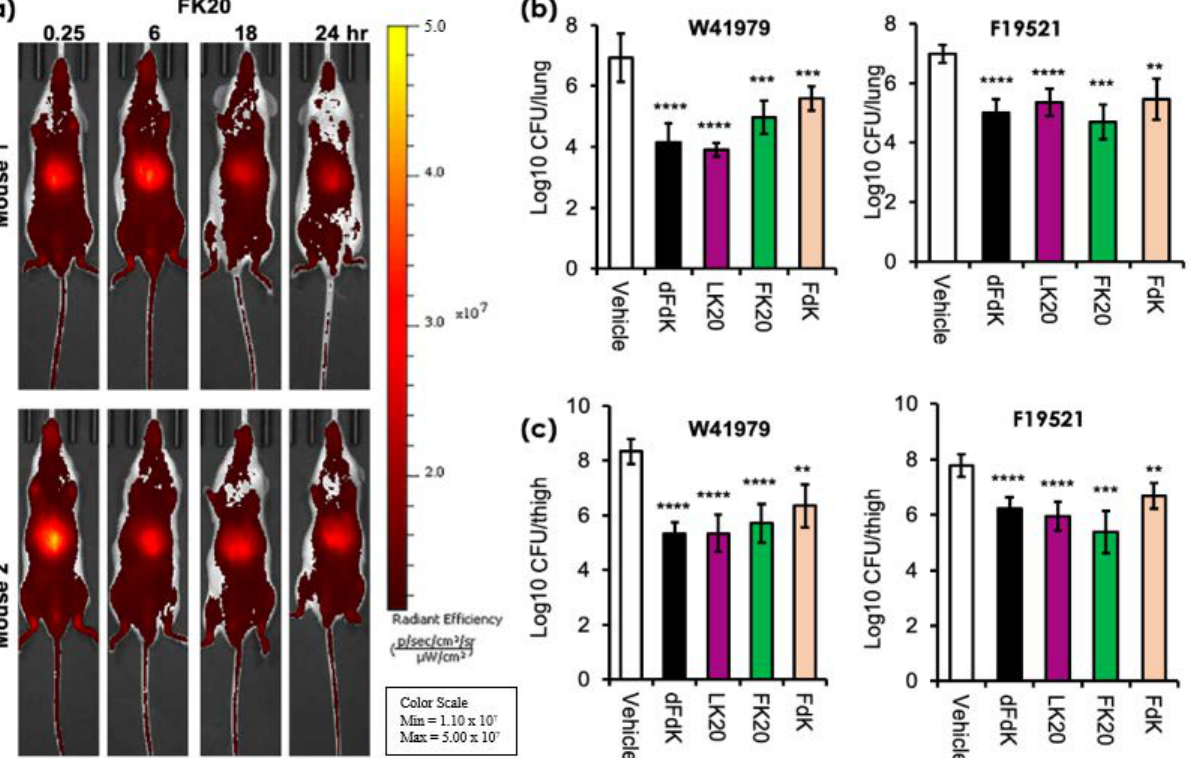
Figure 6. In vivo pharmacodynamics and efficacy of random peptide mixtures (RPMs). ( a ) Phar- macokinetics of intravenously injected Cyanine7.5-labeled FK20 (50 µ g) in CD-1 mice (n = 2) and imaged for 24 h using an IVIS SpectrumCT imaging system. ( b , c ) Effectiveness of RPMs against A. baumannii infection. For acute pneumonia, CD-1 mice (n = 6–8) were intranasally-challenged with A. baumannii strain W41979 (1.4 × 10 8 CFU/mouse) or F19521 (9.2 × 10 7 CFU/mouse). For soft tissue infection, CD1 mice were rendered neutropenic by cyclophosphamide and infected with W41979 (1.1 × 10 5 CFU/mouse) or F19521 (2.7 × 10 5 CFU/mouse) intramuscularly. Infected mice were treated with either 5 mg/kg of each RPM or sterile phosphate buffered saline (vehicle) twice daily, for 2 days before determination of bacterial burden. ** p < 0.01, *** p < 0.001, and **** p < 0.0001 significance compared to respective vehicle controls as determined by the Student’s t